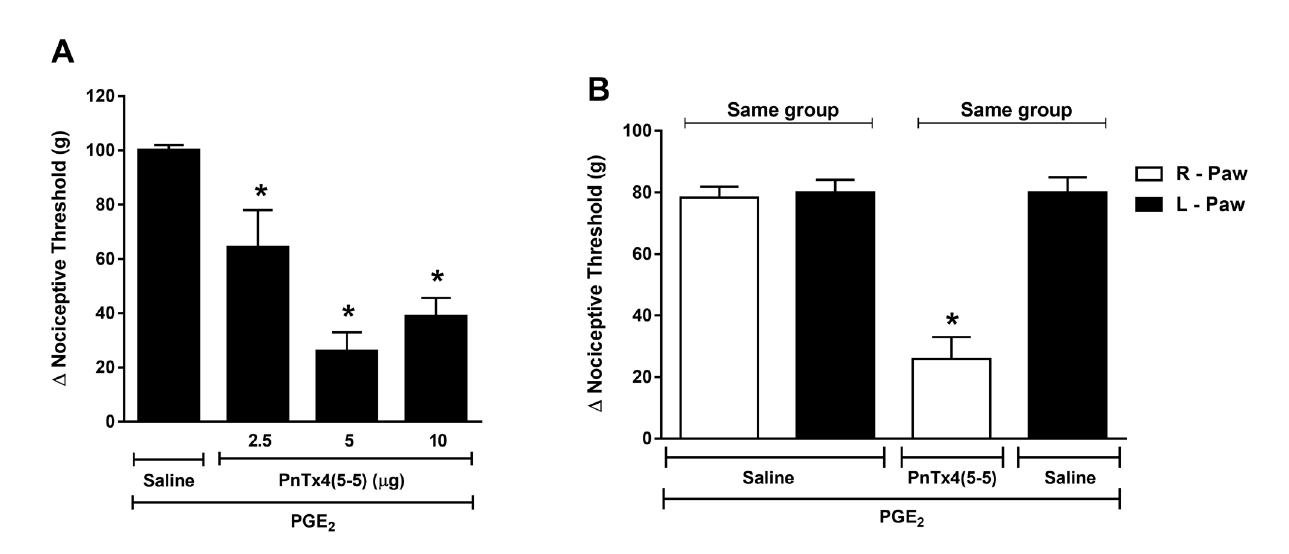
induced hyperalgesia. ( A ) Effect of intraplantar administration of different doses of the PnTx4(5-5) (2.5, 5 and 10 µg) on Figure 3. Effect of PnTx4(5-5) on PGE 2 hyperalgesia induced by PGE (2 µg/paw). PnTx4(5-5) was administered 150 minutes after PGE 2 at a dose of 5 µg. Toxin or saline were injected into the right paw (RP) 150 minutes after administration of PGE represents the mean ± S.E.M. of Δ nociceptive threshold (g) for four animals. *Indicates statistical significant difference (p < 0.05) from the group control (PGE saline - R-Paw).